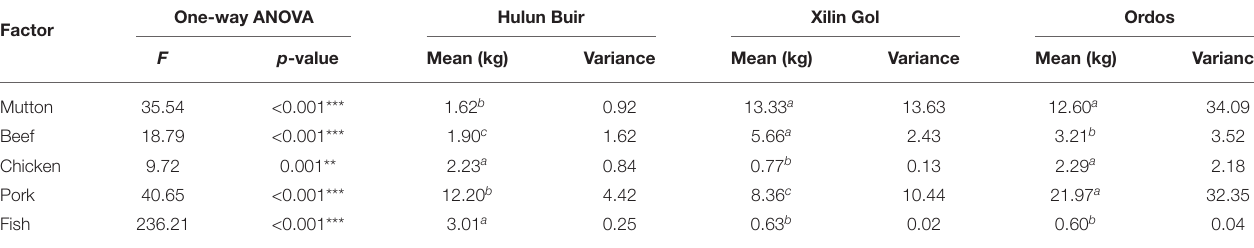
TABLE 6 | Meat consumed by residents at all three study sites (2000–2012